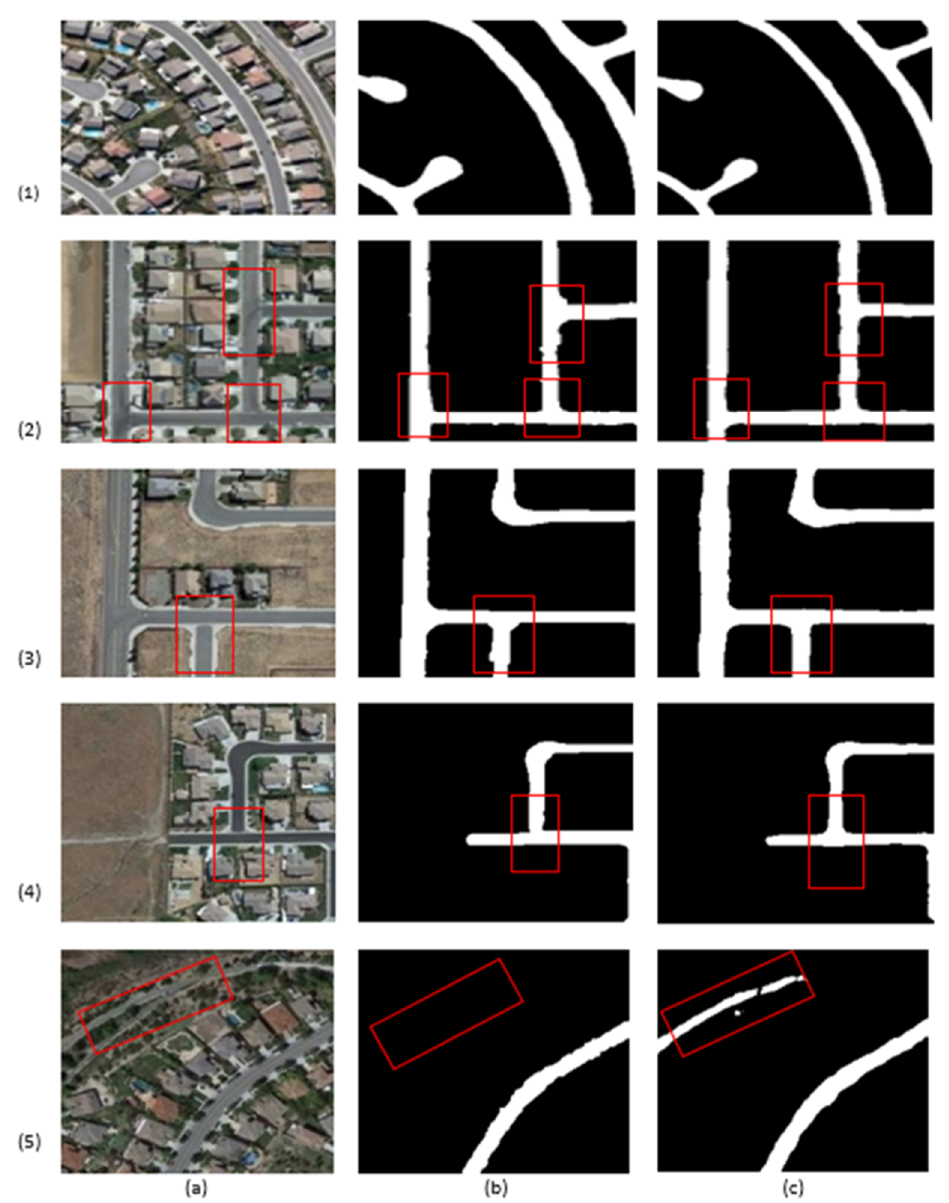
Figure 3. Comparisons of ( a ) the original images, ( b ) the ground truth images, and ( c ) the predictions of the proposed model.